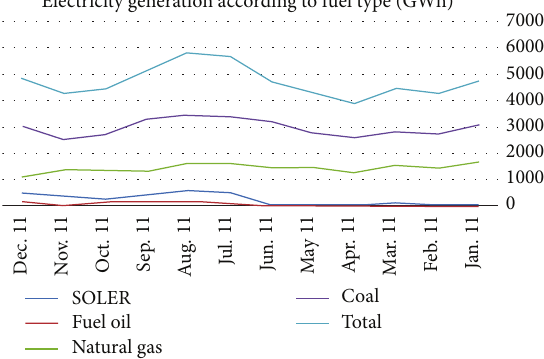
Figure 1: 2011 generation according to fuel